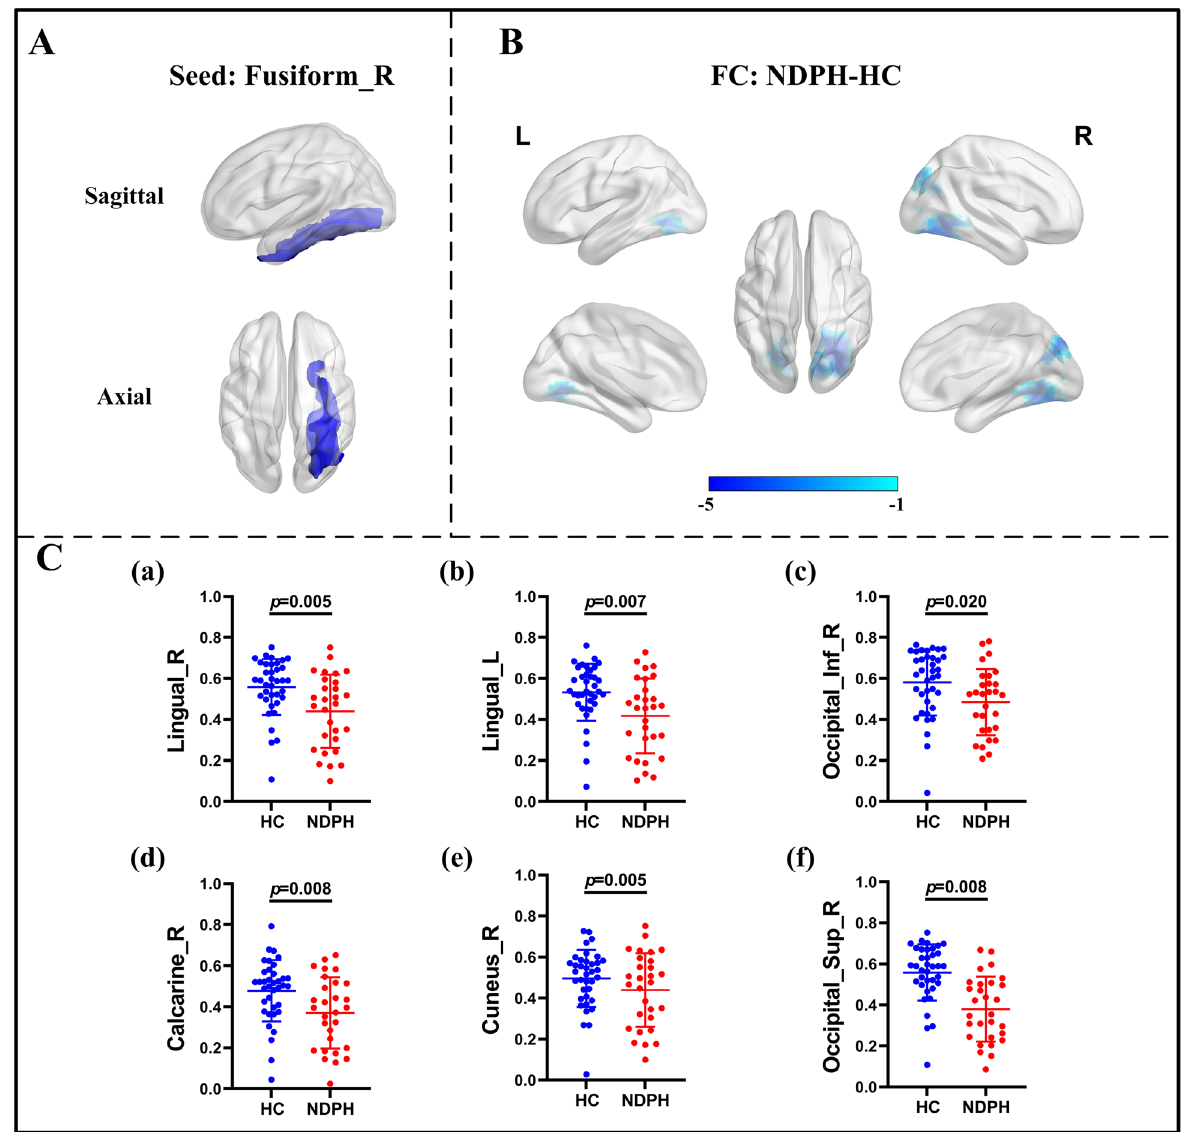
Fig. 3 FC analysis from right fusiform gyrus to the whole brain voxels in NDPH and HC groups. A The schematic diagram of the seed (right fusiform gyrus). The brain region marked in blue represents the right fusiform gyrus. B The schematic diagram of significant FC differences. Compared with HCs, patients with NDPH showed significantly decreased FC between the seed and bilateral lingual gyrus, right inferior occipital gyrus, right calcarine, right cuneus, right superior occipital gyrus. C (a) to (f) represented FC values between the seed and bilateral lingual gyrus, right inferior occipital gyrus, right calcarine, right cuneus, right superior occipital gyrus respectively in HC group and patients with NDPH. Notes: The color bar showed t-values of the two-sample t-tests on FC. Abbreviations: L, left; R, right; Sup, superior; Inf, inferior; FC, functional connectivity; NDPH, new daily persistent headache; HC, health